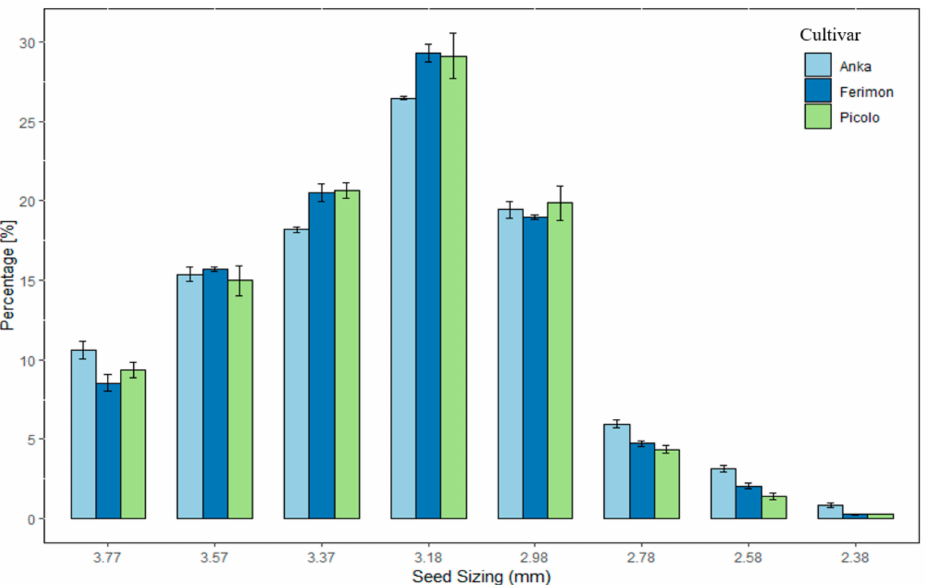
Figure 5. Hemp seed-size distribution for ‘Anka’, ‘Ferimon’ and ‘Picolo’. Data are means ± SE of three seed lots (each consisting of 100 g) per cultivar.